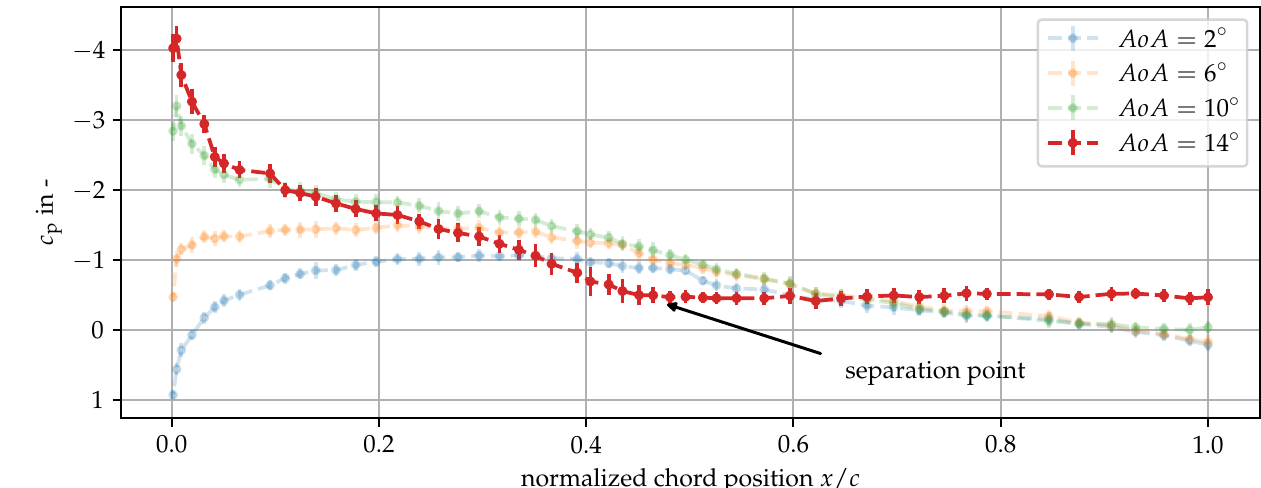
Figure 6. Distribution of experimental determined dimensionless pressure coefficients c p on the suction side of the airfoil of type DU96W180 for a Reynolds numbers of Re = 2 · 10 6 .